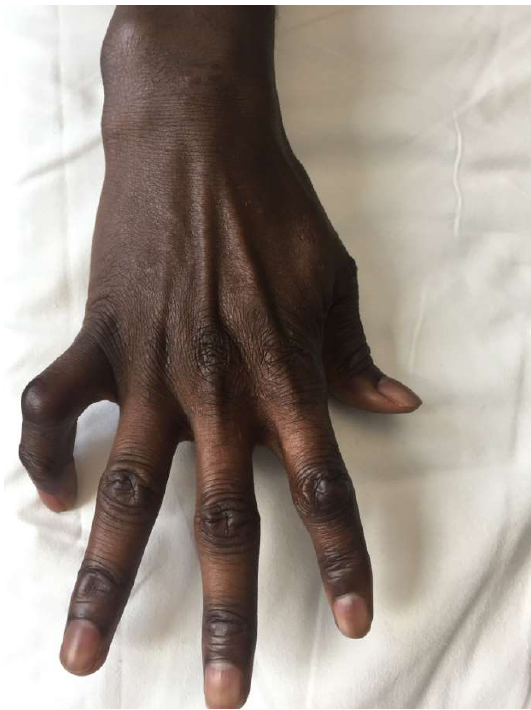
Figure 3. Hypotrophy of the hypothenar region with the flexion of the fifth proximal interphalangeal joint in a 37-years old migrant from Senegal with a diagnosis of tuberculoid leprosy. Microorganisms 2020 , 8 , x FOR PEER REVIEW